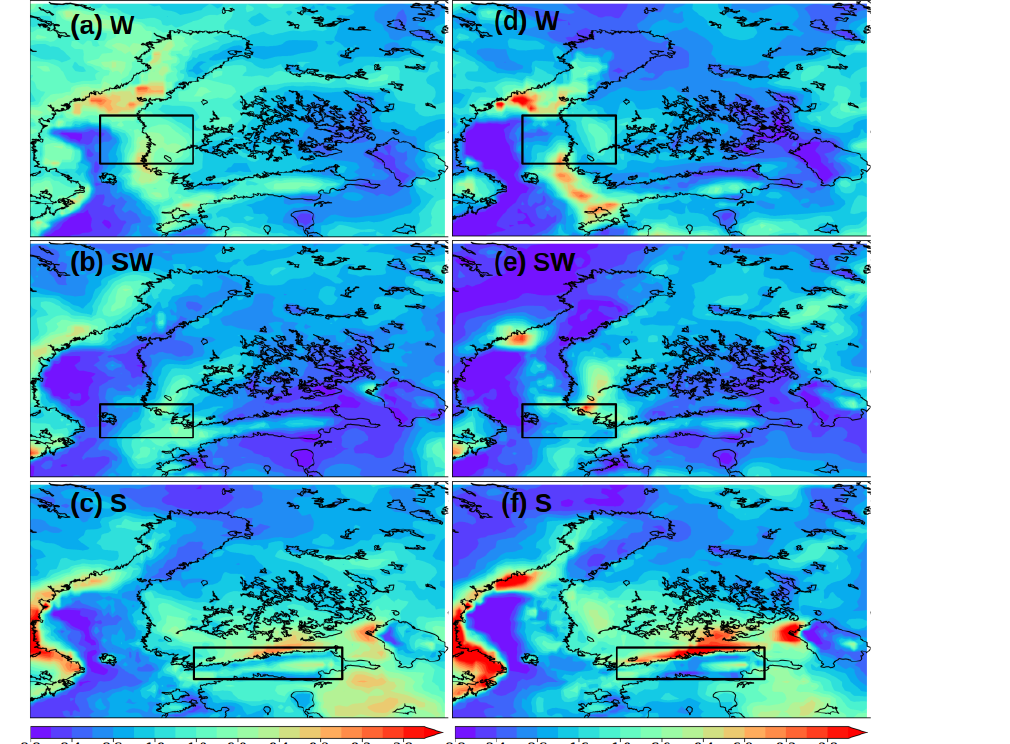
Figure 4. Average daily snowfall amount (mmd − 1 ) during 2000–2010 with 10m wind speed of 7ms − 1 (a-c) and 10ms − 1 (d–f) whenever there were favorable conditions to bring sea-effect snowfall towards the coast in areas W (a, d) , SW (b, e) and S (c, f) (as in Fig. 2, Table 1) based on RCA4